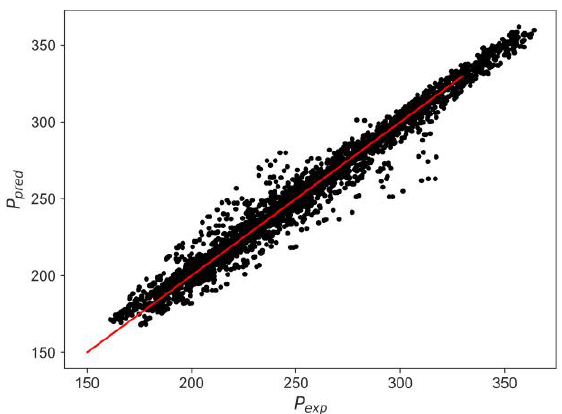
Figure 22. Test pressure vs. calculated KNN of PASN/water blend. Note: red line represents a perfect prediction.